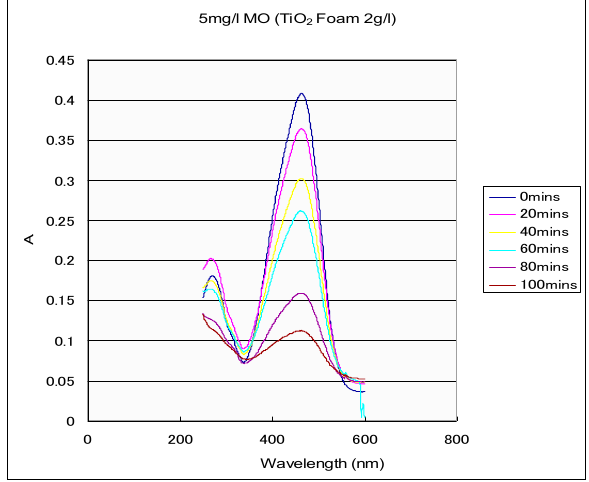
Figure 5. The photocatalytic degradation of an anionic azo-dye in a UV irradiated porous titania foam [8,86]. The decrease in absorption peaks is an evidence of degradation. This evidence cannot however be conclusive (see section 4-on the use model compounds in this review).